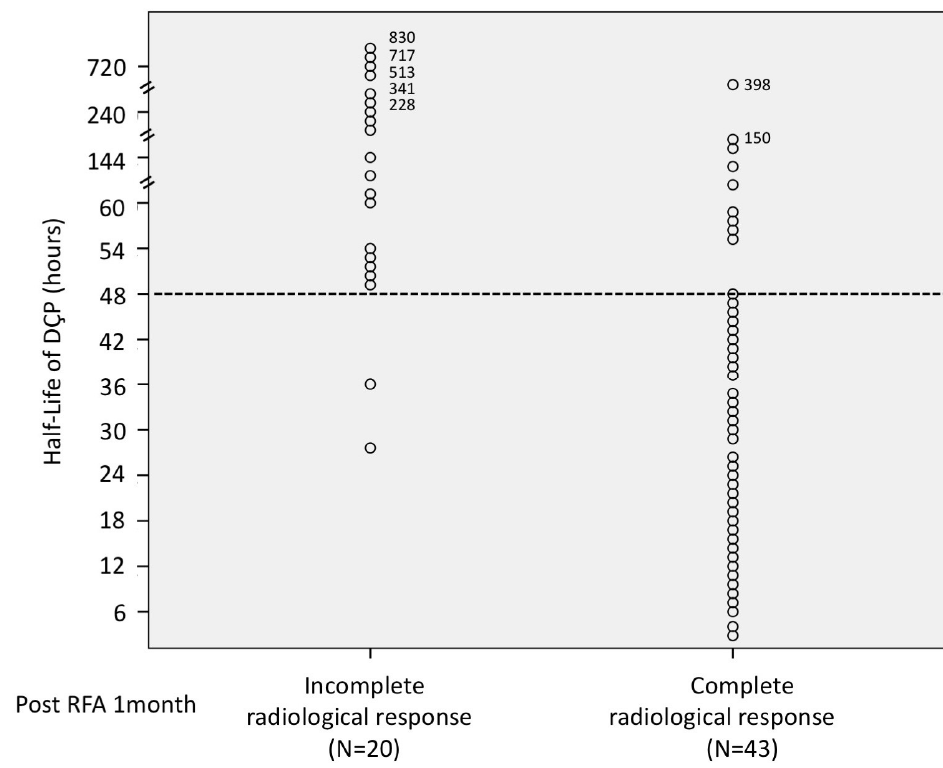
Figure 2. The distribution of 63 patients’ HLs of Des-gamma-carboxy prothrombin (DCP) stratified according to the radiofrequency ablation therapies (RFA) treatment response at 1 month post ablation.